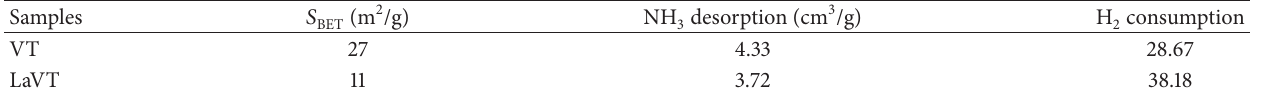
Table 1: Results of physicochemical characterization of studied samples.